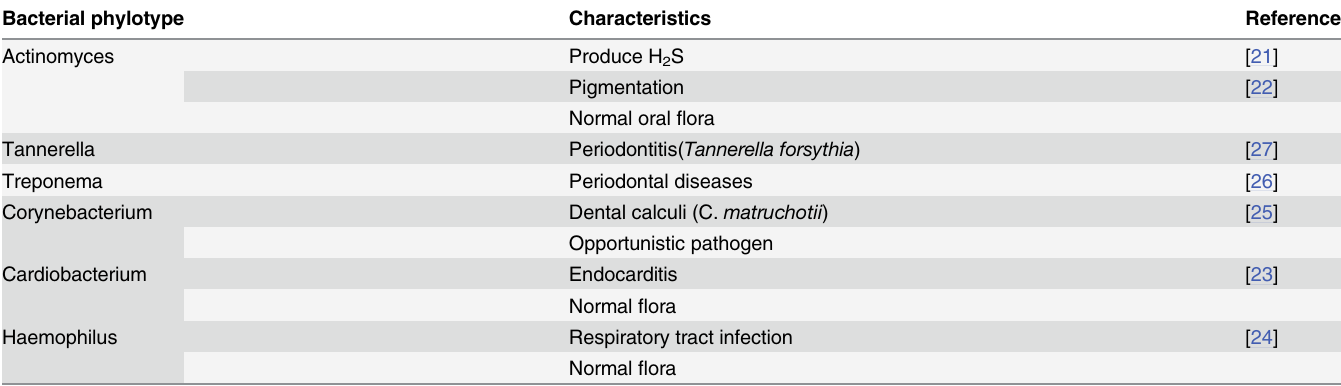
Table 1. Bacterial phylotype that were more abundant in children with black